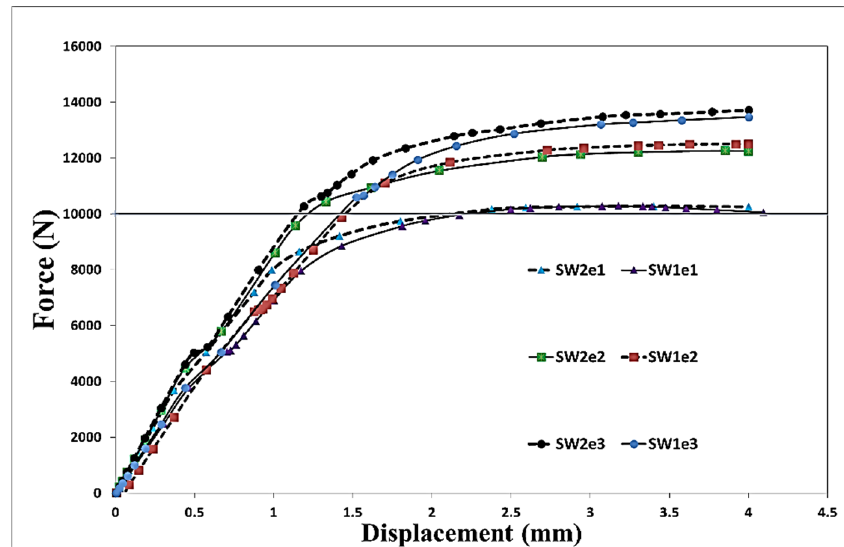
Figure 4. Numerical load-displacement curves of single bolt joints with different